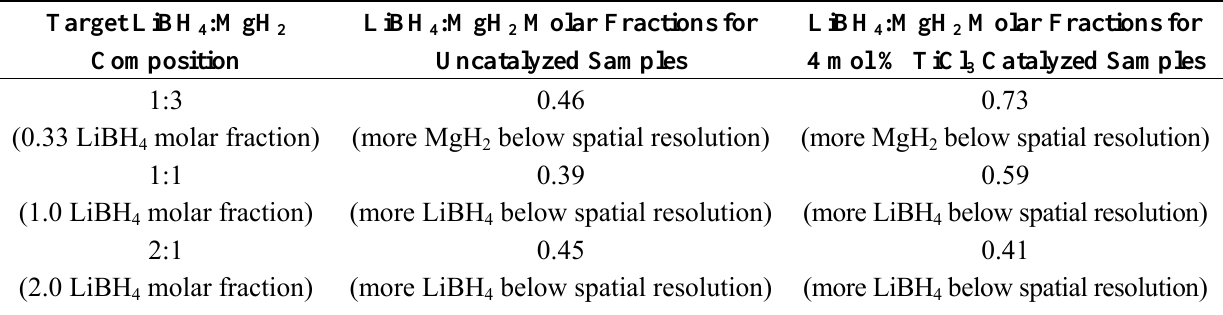
Table 2. LiBH :MgH molar ratios computed from microtomographic image analysis for 4 2 catalyzed and uncatalyzed systems. Poor correlations between the target molar ratios of 0.3, 1.0 and 2.0 may be explained if high energy ball milling preferentially reduces particle sizes for the most abundant phase in the mixture.